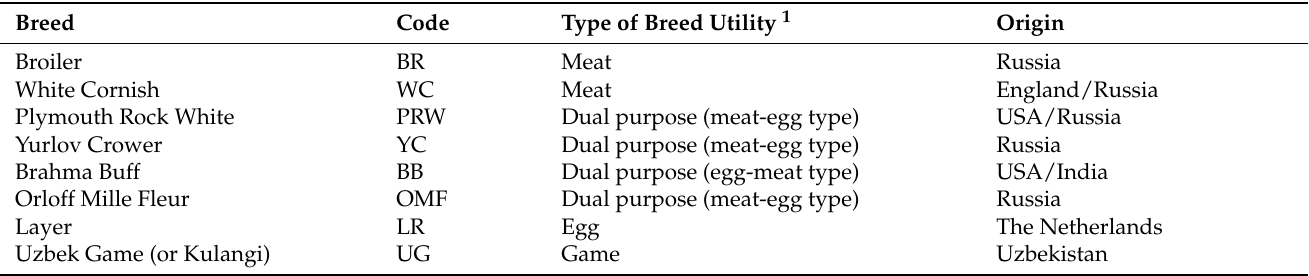
Table 1. List of the studied chicken